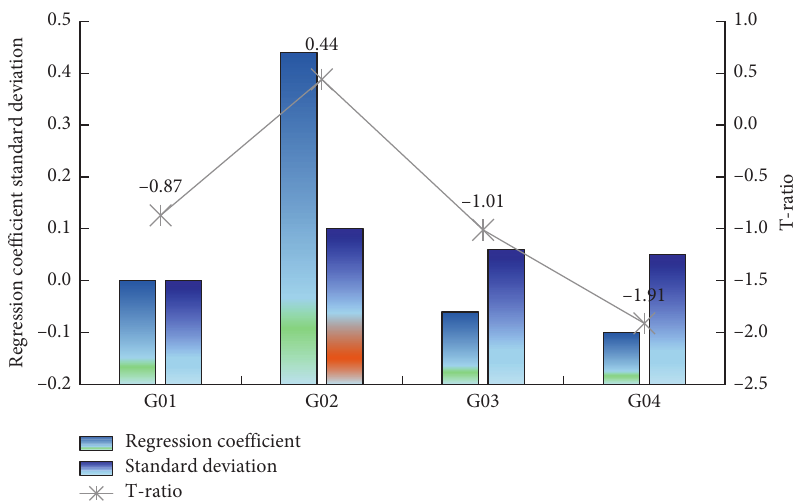
Figure 9: Results of the multilevel linear regression model of objective factors and social service satisfaction.